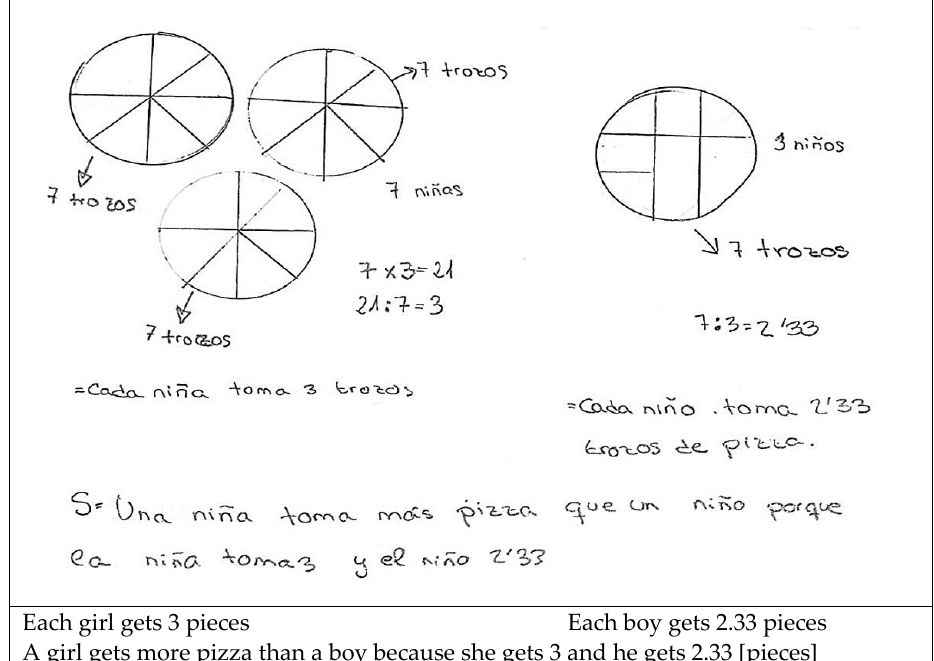
Figure 8. Combination of various mathematical contents to find the solution.